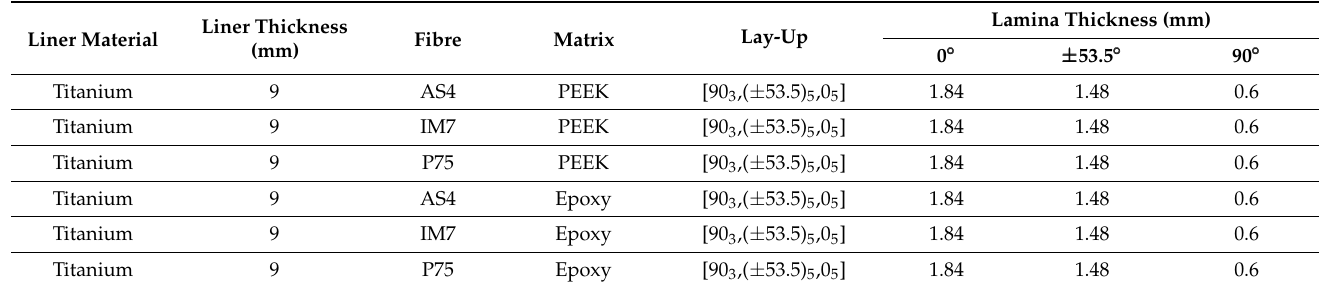
Table 4. Selected design, stack-up sequences, material configurations, and CPR’s composite lamina orientations.